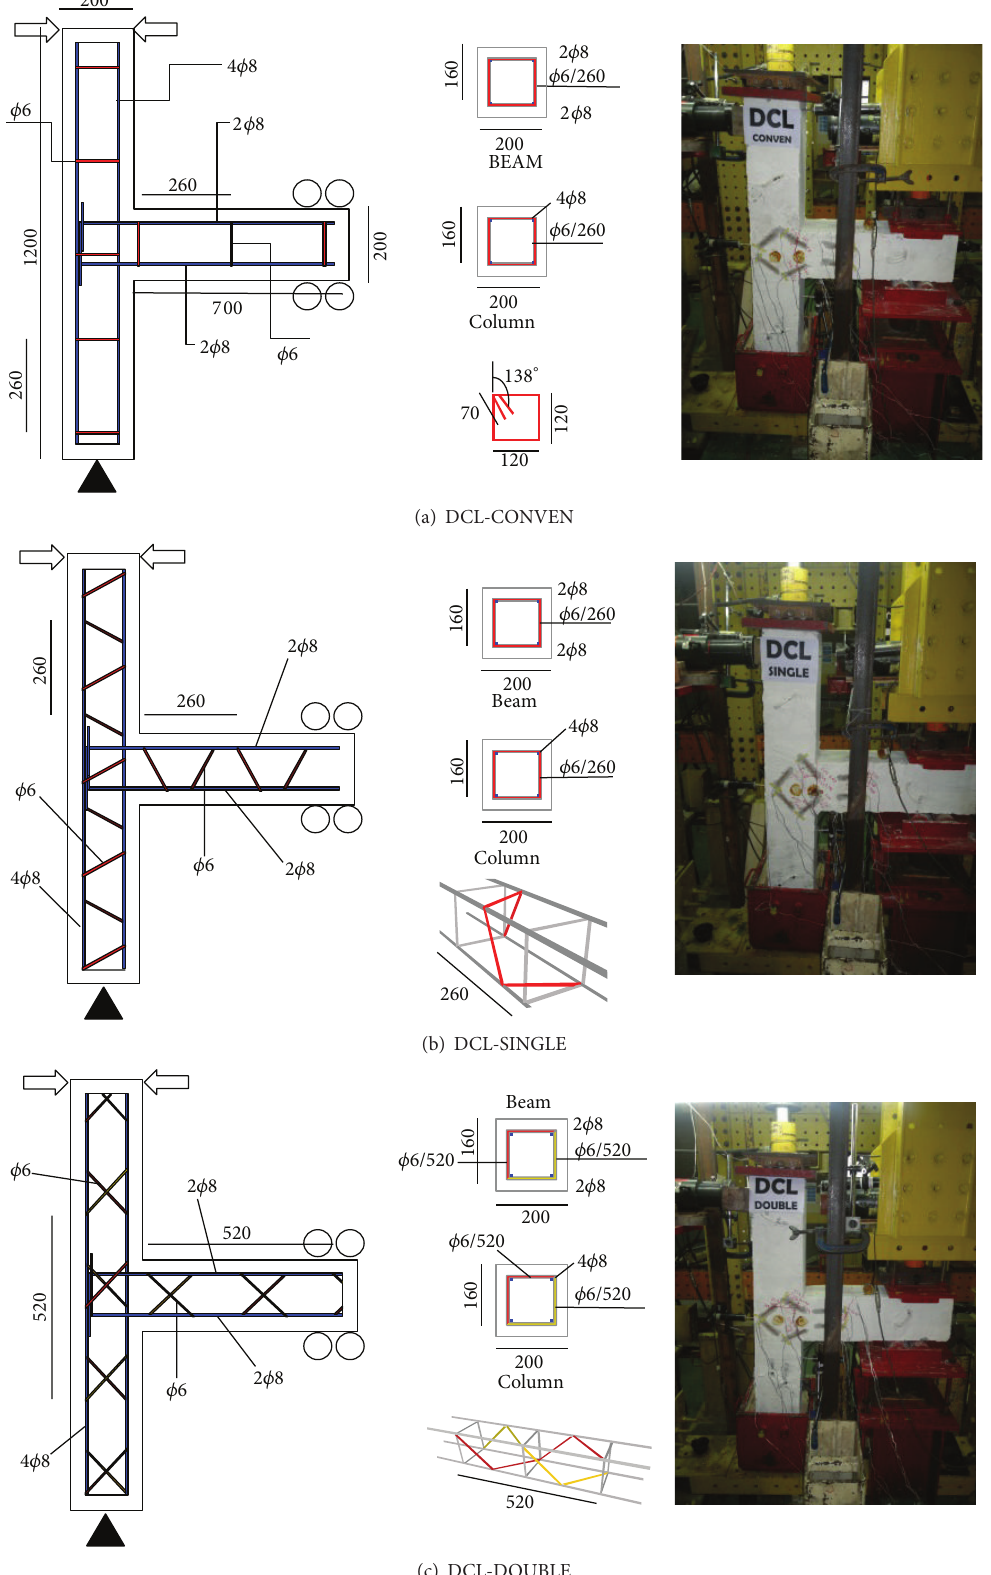
Figure 2: Geometry and steel reinforcement of the tested specimens, (a) DCL-CONVEN, (b) DCL-SINGLE, and (c)